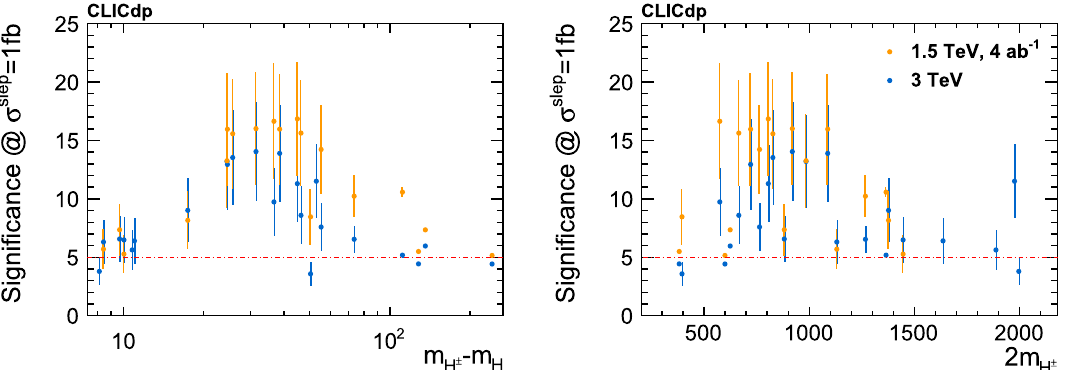
Fig. 8 Expected statistical significance of IDM charged scalar pair-production observation, assuming the semi-leptonic channel cross section of m H (left) and of the total mass of the produced IDM scalars, 2 m H 1fb: as a function of the IDM scalar mass difference, m H (right). Results ± − ± of the Delphes fast simulation study are presented for CLIC running at 1.5TeV (orange circles) and 3TeV (blue points) with 4ab − 1 of integrated luminosity assumed for both stages. Error bars indicate the systematic uncertainty, estimated from the observed difference between fast and full simulation results, see text for details. The red horizontal lines indicate the 5 σ